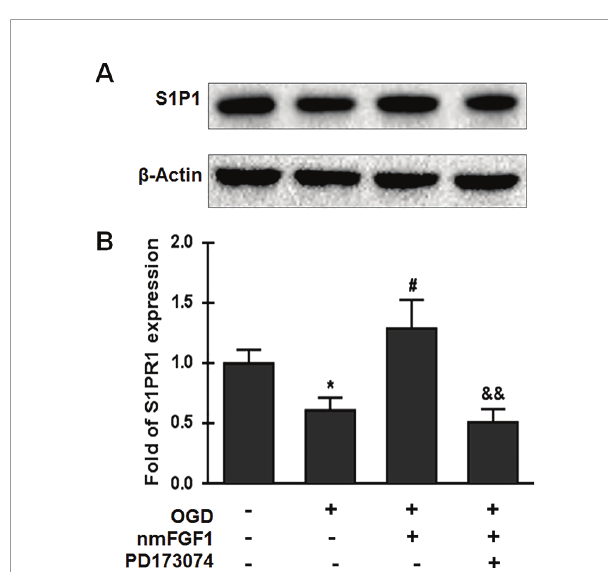
FIGURE 8 | Non-mitogenic fi broblast growth factor 1 (nmFGF1) rescued oxygen-glucose deprivation (OGD)/R-induced downregulation of S1P1 expression by FGFR1 activation. (A) Representative western blots for S1P1 expression. (B) Quanti fi cation of the relative expression level of S1P1. Date are expressed as the means ± SEM (n = 4). *p < 0.05 as compared to the control group, # p < 0.05 as compared to the OGD-treated group, && p < 0.01 as compared to the nmFGF1-treated group.